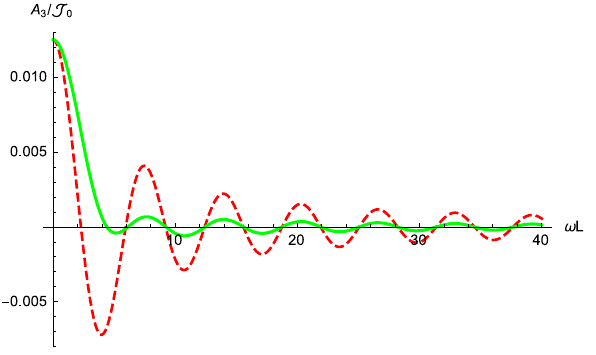
Fig. 2 The coefficient A 3 as a function of ω L . The red dashed line and green solid line correspond to two different polarizations of the subsystems respectively, i.e. q | q | , with other components being